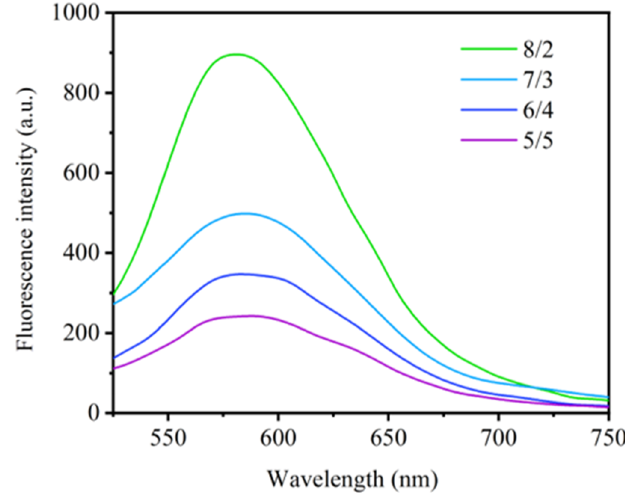
Figure 4. Fluorescence spectra of CMC−GE−AQ in DMF/H 2 O solvents with different DMF proportions. (CMC−GE−AQ: 1.5 × 10 −4 g mL −1 ; solvents: pH = 7; excitation wavelength: 425 nm; excitation slit: 5 nm.)